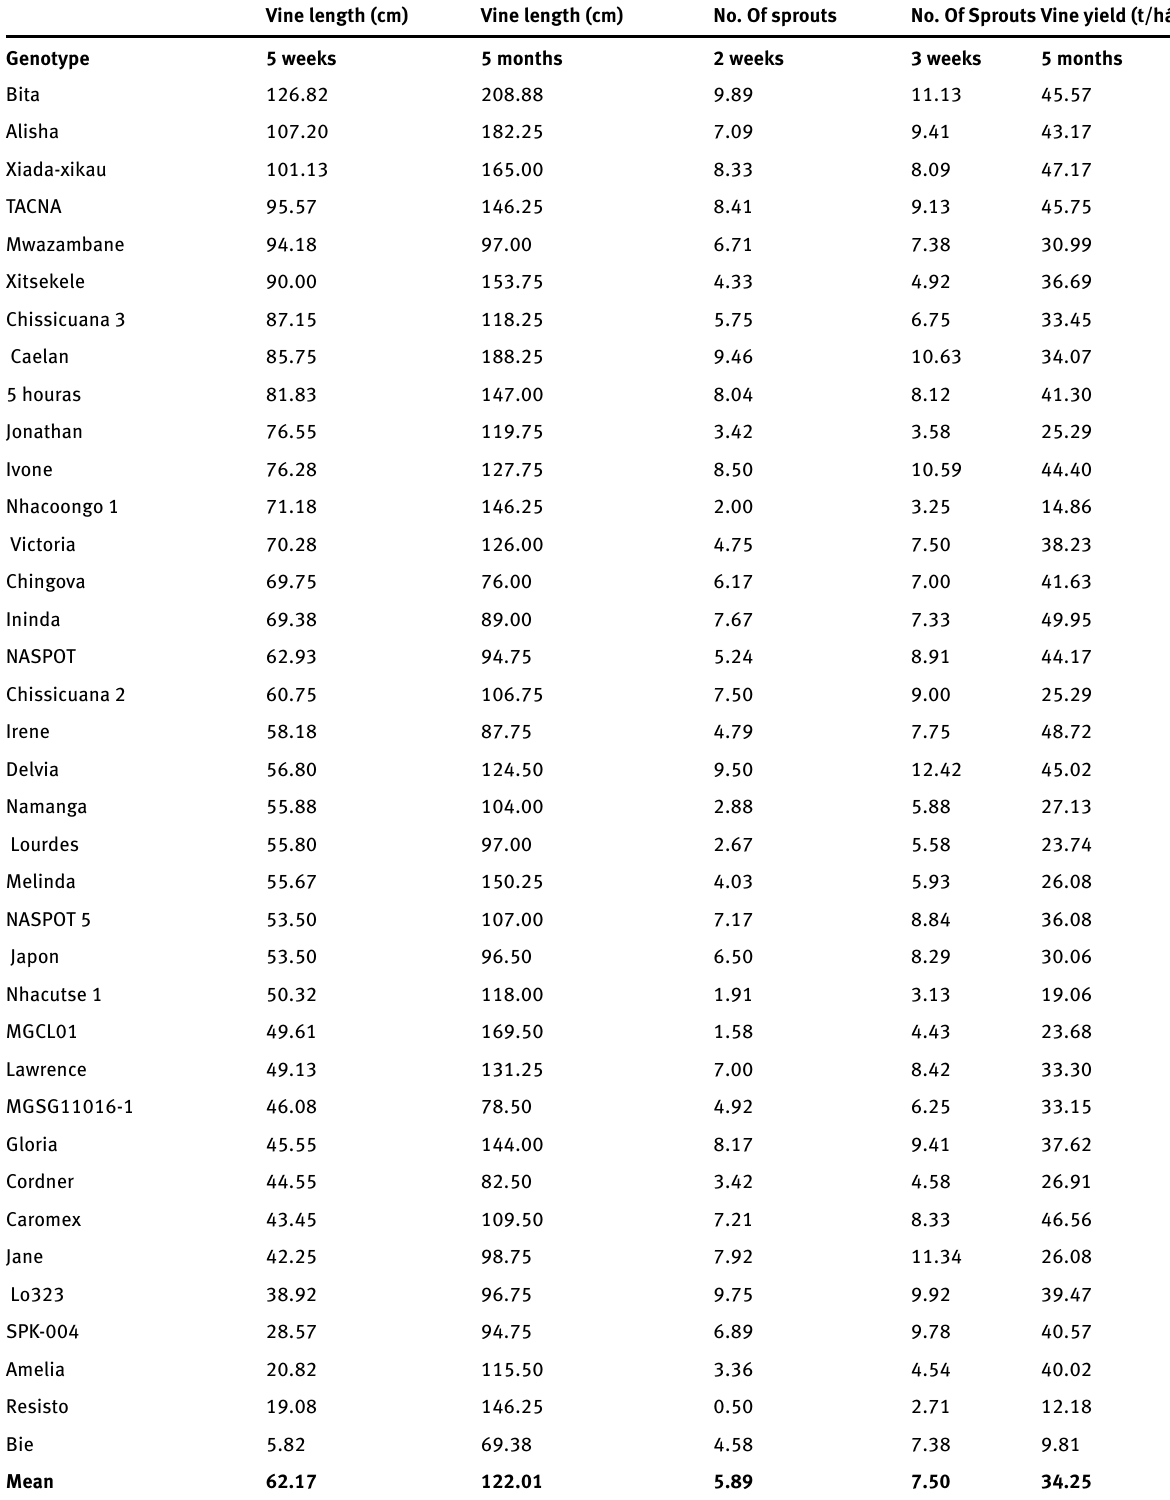
Table 4: Results of the sprouting experiments at Umbeluzi, Nwalate and Gurue Research Stations in 2015 with number of sprouts during the second and third week as well as vine length at 5 weeks recorded. Vine length and yield were estimated as well at five months after the